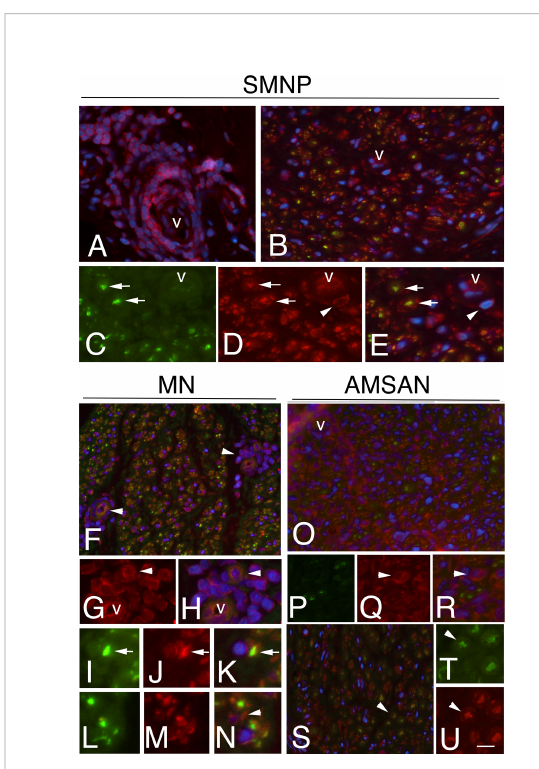
FIGURE 5 RPS27 expression in sural nerves of NL. Transverse sural nerves sections from SMPN, MN and AMSAN double-stained for RPS27 (red) and neuro fi lament (NF, green), to recognize axons. DAPI staining of nuclei (blue). Co-expression of NF and RPS27 by the same cell results in overlapping of the fl uors, and appears yellow. SMNP: RPS27 immunoreactivity was present in epineurial malignant B-cells ( A , v marks an epineurial vessel) and in endoneurium (B) ; RPS27 shows expression in axons (arrows, C , D , merge in E ) and Schwann cells ( D, E , arrowheads). MN: RPS27 immunoreactivity of perivascular malignant B-cells in endoneurium ( F-H , arrowhead, v marks a vessel), axons ( I-K , arrows) and Schwann cells ( l-N , arrowhead). RPS27 shows a diffuse increase expression in the endoneurium of nerve from a patient with AMSAN, including malignant B-cells (O-R arrowhead) ( O , v marks a vessel) and axons ( S - U , arrowheads). Scale bar represent 20 m m (A, B, F, O, R) ; 10 m m; (C-E, G-N, S-U) .